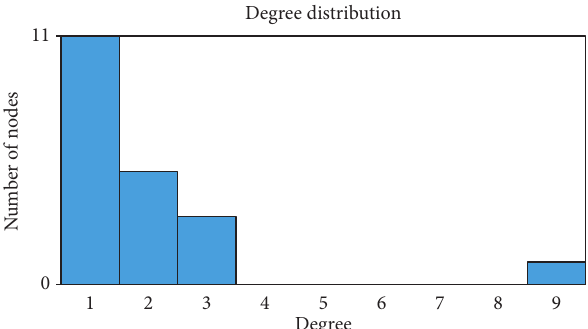
Figure 5: Degree distribution of the aggregate when the number of agents is 20.